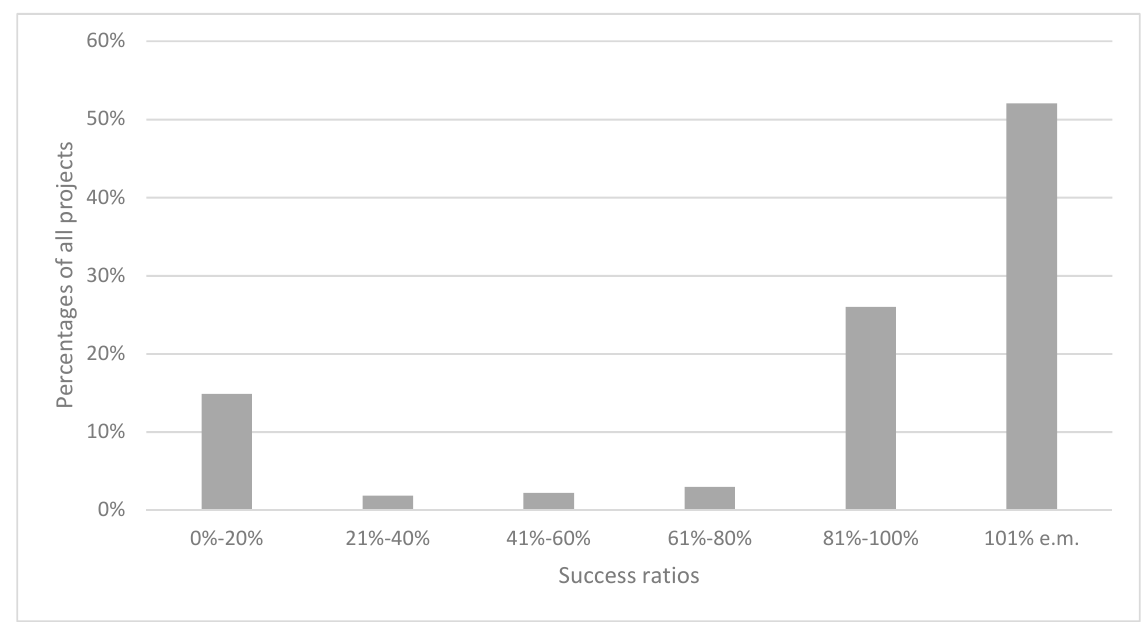
Figure 1. Distribution of success ratios of 269 civic crowdfunding projects, i.e., ratios of realized earnings and target earnings (vertical axis: percentage of all projects; horizontal axis: success ratios of civic crowdfunding projects).